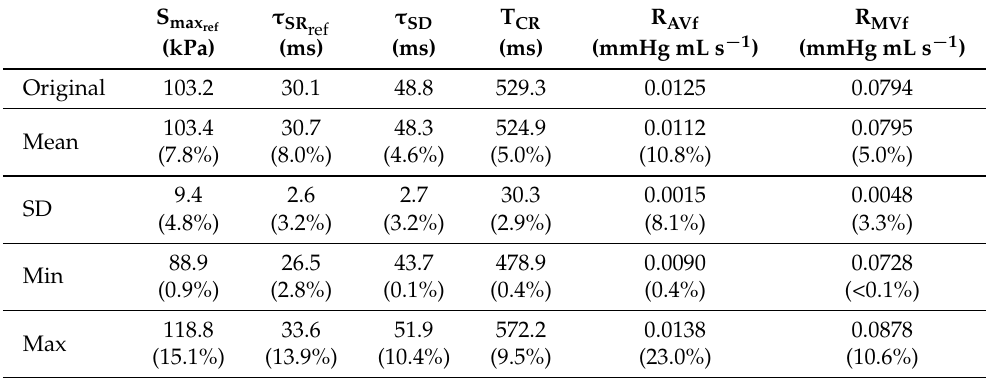
Table 3. Results of the clinical data uncertainty robustness analysis for the patient case 02-CoA. Estimated model parameter values of the first step of the active mechanics personalisation approach are given. The original values are listed in the first row and means (M), standard deviations (SD), minima (Min), and maxima (Max) of ten samples are listed in the subsequent rows. Means, standard deviations, minima, and maxima of the relative differences are given in brackets below.